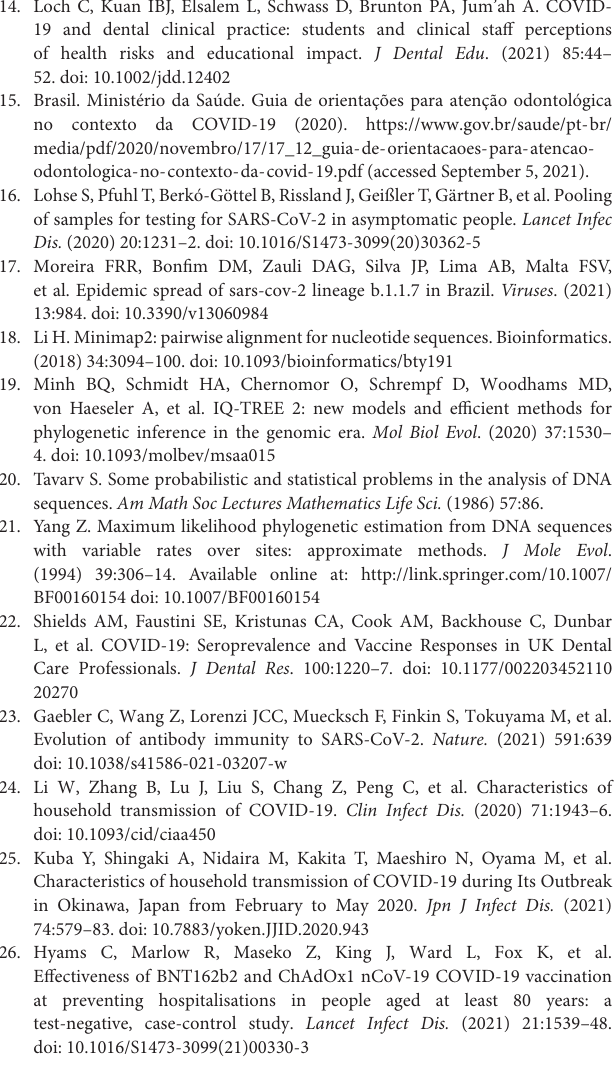
on samples with Ct<30 to N1 and N2 SARS-CoV-2 genes. ( ‡ ) S#55 is the unique student who worked without a partner. Supplementary Figure 6 | IgG and IgM positive results in dental healthcare professionals during the nine weeks observed. (A) Shows IgM positive results. (B) Shows the number of IgG positive results. (C) Demonstrate the double IgM and IgG positive results. Black lines represent cumulative positive results. Supplementary Figure 7 | Environmental results of samples collected from surfaces of each workstation (WS) collected in the eighth and ninth weeks. The figure illustrates different areas detected between the two weeks. The patient positive for COVID-19 was assisted in the eighth week at workstation#2 where indeterminate samples were on the sink bench, detergent dispenser, air sample, instrument table handle, and internal part of the saliva ejector were found (Ct = 35 ± 2 for N1 gene). Supplementary Figure 8 | Phylogenetic tree of variants in Belo Horizonte City and the variants detected in dental healthcare professionals (highlighted in the purple circle). Sequenced samples resulted in a total of 183,560.5 reads with a genome span above 79.5% (mean: 89.6 ± 10.1%). The sequencing depth of the two samples were at least 740x (Mean 1226.0 ±